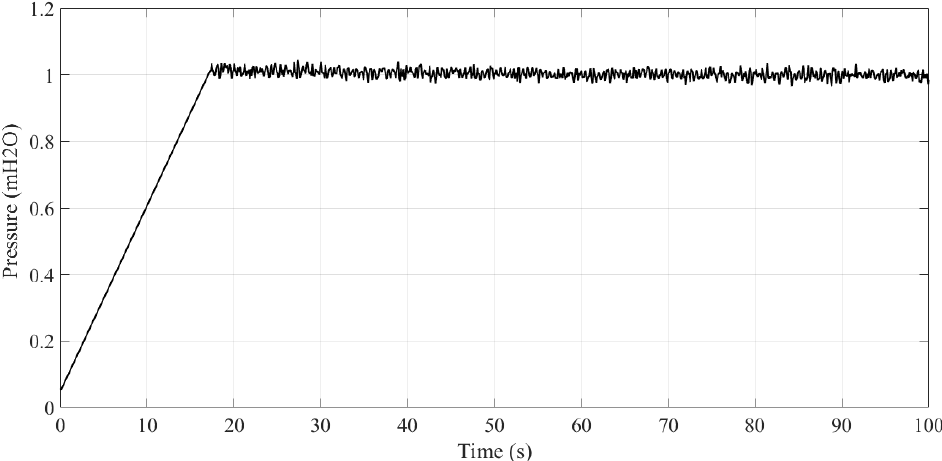
Figure 5. Normalized unit step response of the open loop